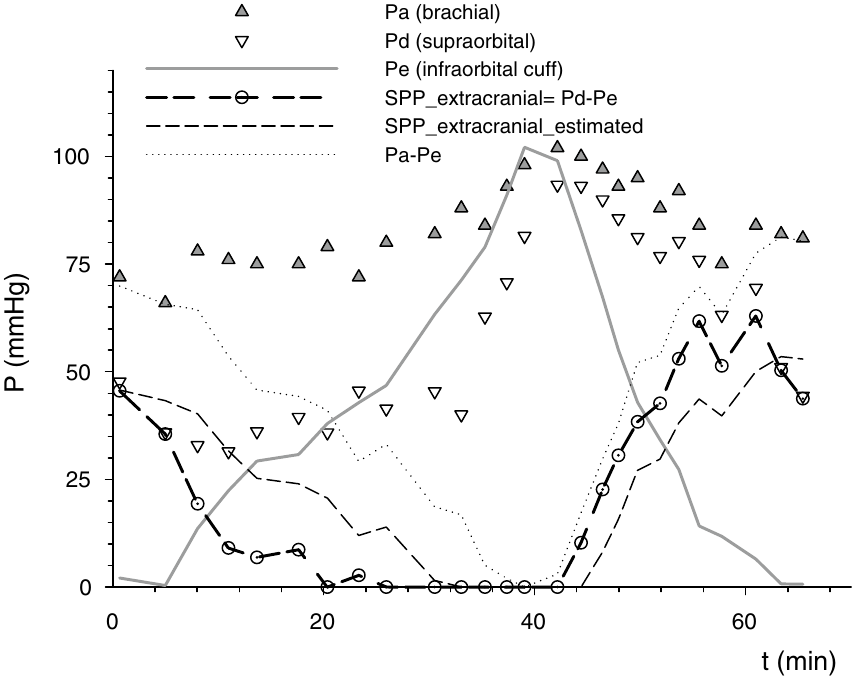
Figure 5. In-vivo measurement of supraorbital pressure with extracranial outflow manipulation: mean systemic pressure Pa was measured using the oscillometric method in the recumbent awake volunteer. Supraorbital pressure Pd (intra-extracranial collateral) was detected by registering maximal photoplethysmographic oscillation during graded compression. At the same time, inflatable infraorbital cuff controlled extracranial outflow pressure Pe. SPP_estimated was calculated using the SPP equation, with fractional flow reserve 0.66, obtained during first measurement, relative extracranial conductance 0.5, and intracranial pressure 0. SPP was assigned the value of 0, when Pe exceeded Pd (complete extracranial outflow obstruction). Extracranial perfusion pressure (Pa–Pe)—the extracranial equivalent of cerebral perfusion pressure—was higher than segmental perfusion pressure (difference 24.6 ± 2.7 mm Hg, P < 0.001), whereas there was no significant difference between SPP_extracranial and it’s estimated value SPP_extracranial_estimated (difference 0.8 ±